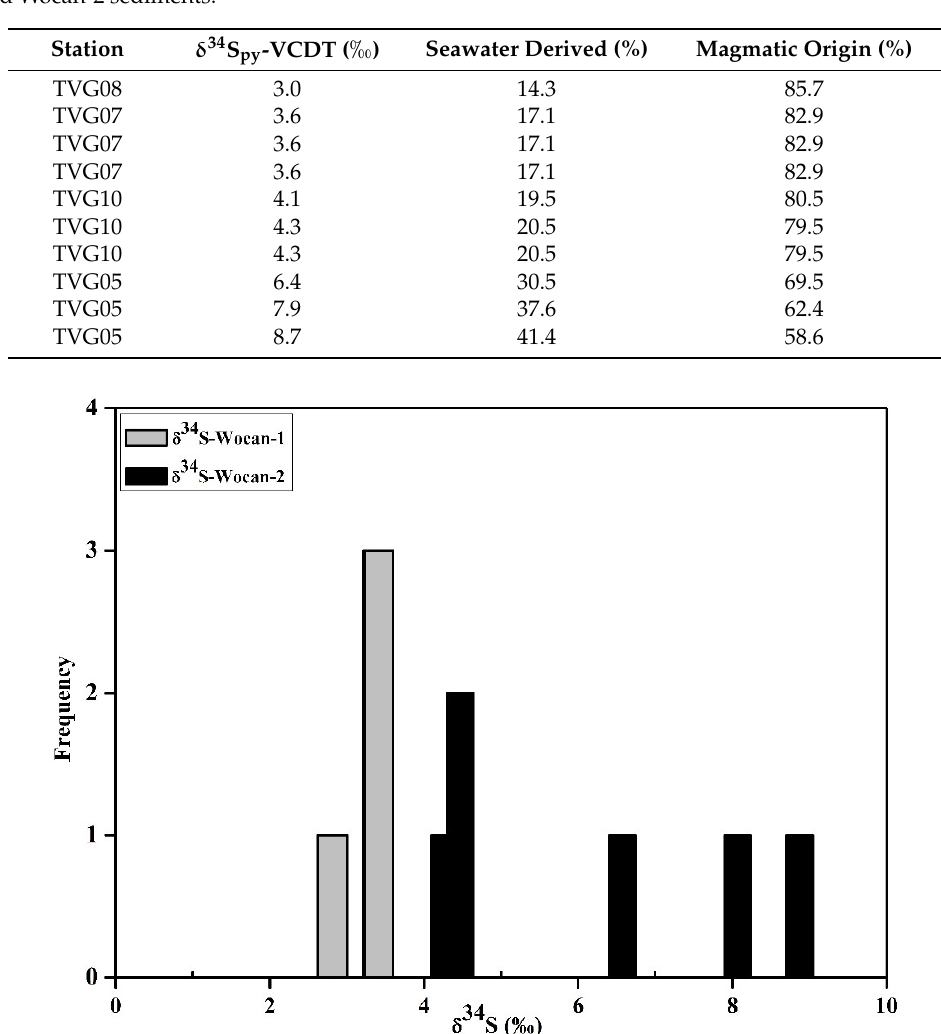
of Wocan-1 and Wocan-2 (cid:104)